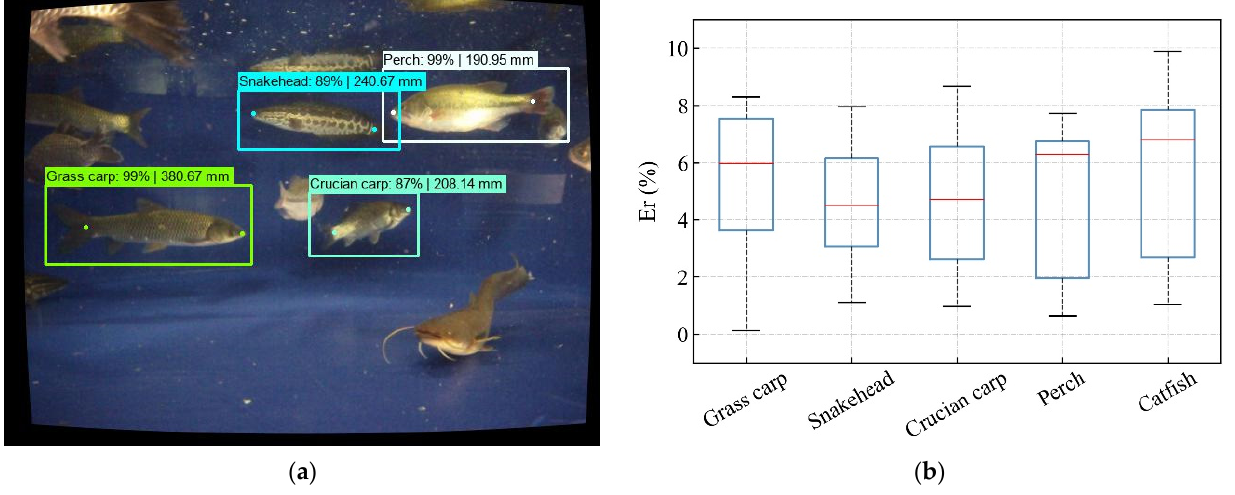
Figure 8. The results of the fish length measurement experiment, ( a ) result mark on the original image, ( b ) relative errors of the length measuring.